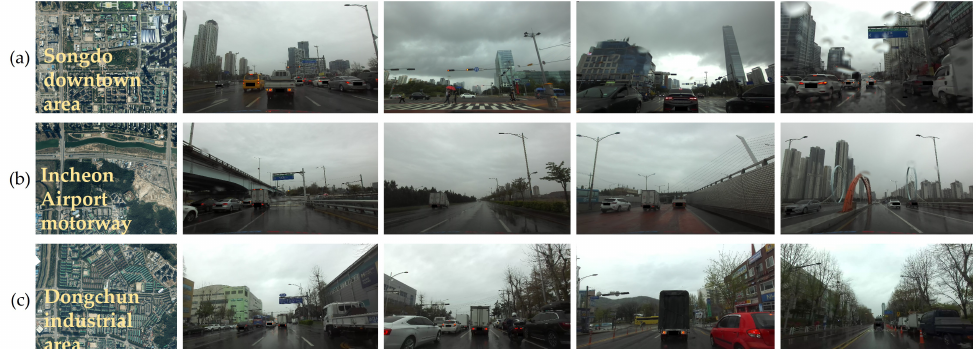
Figure 6. Recording environments: ( a ) Songdo downtown area; ( b ) Incheon Airport motorway; ( c ) Dongchun industrial area. Satellite images (1st column) and sample images (2nd–5th columns) of the three areas show the infrastructure